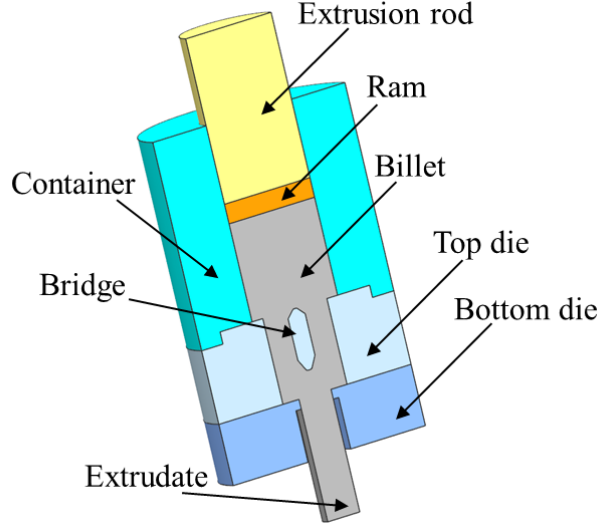
Figure 3. Porthole Figure 3. Porthole die.